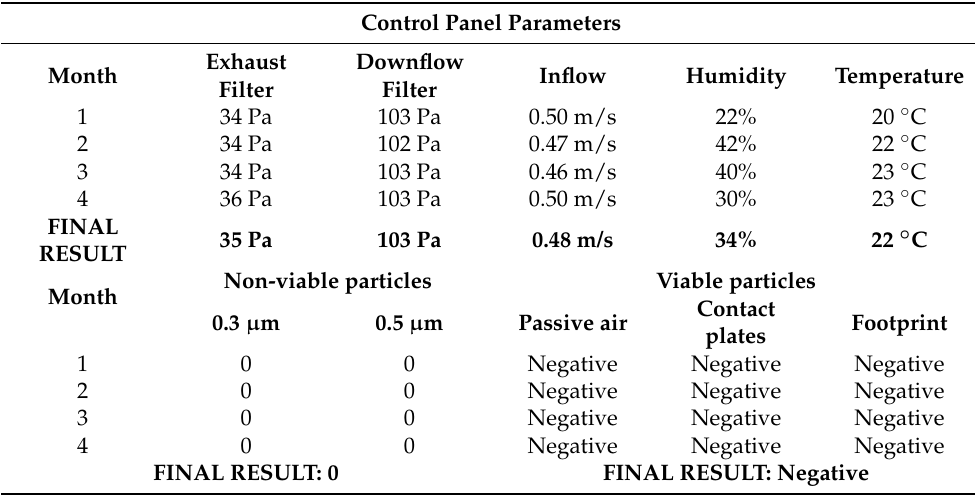
Table 5. Performance qualification